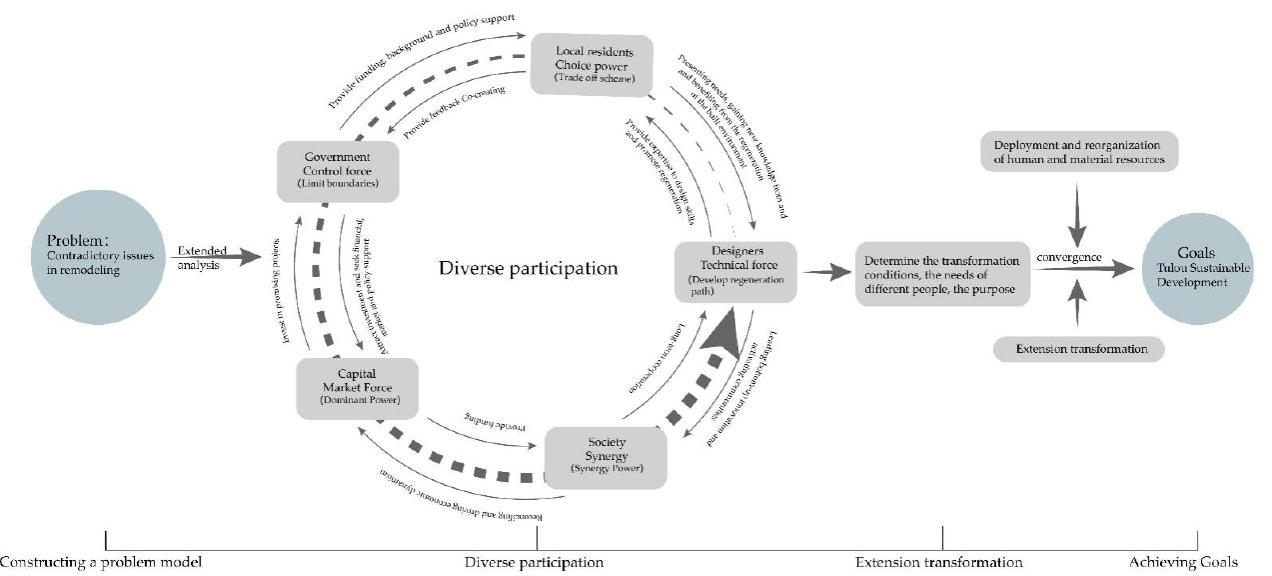
Figure 14. Extension analysis diagram of multiple participation [50] .